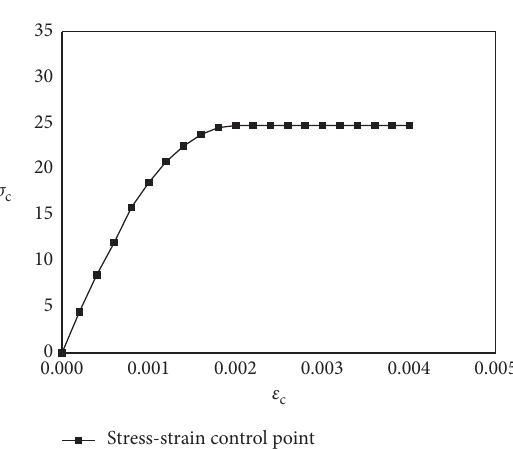
Figure 12: 3D model.